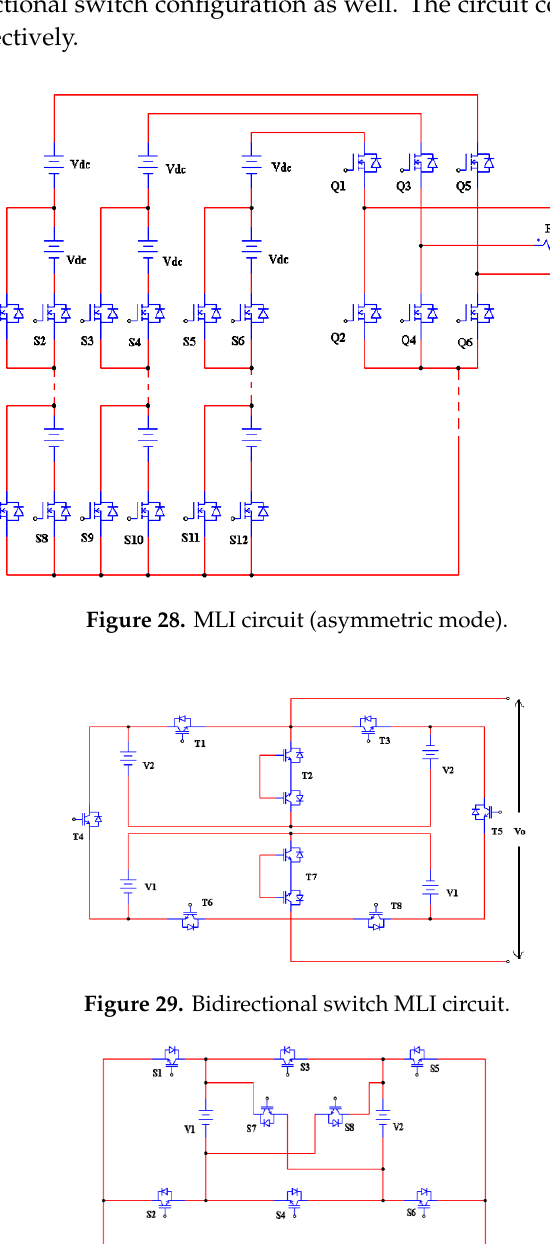
Figure 29. Bidirectional switch MLI circuit.